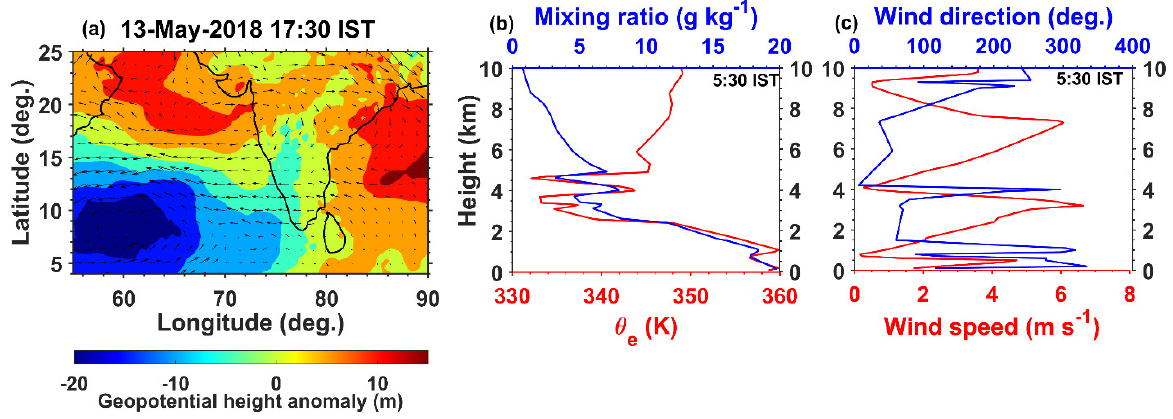
Figure 7. ( a ) Horizontal wind vectors overlaid with geopotential height anomaly on 13 May 2018 at 12 UTC using ERA5 dataset. ( b ) Vertical profiles of θ e (red) and mixing ratio (blue), ( c ) vertical profiles of wind speed (red) and wind direction (blue) on 13 May 2018 at 12 UTC from radiosonde measurements.